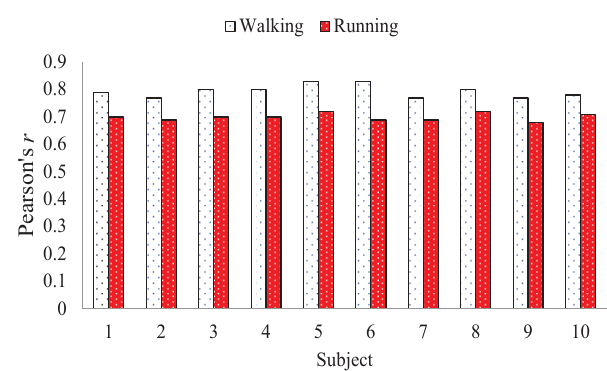
Figure 7: The Pearson’s correlation coefficients of the linear correlation between the estimated results CEE volt and the input signal vector X for all ten